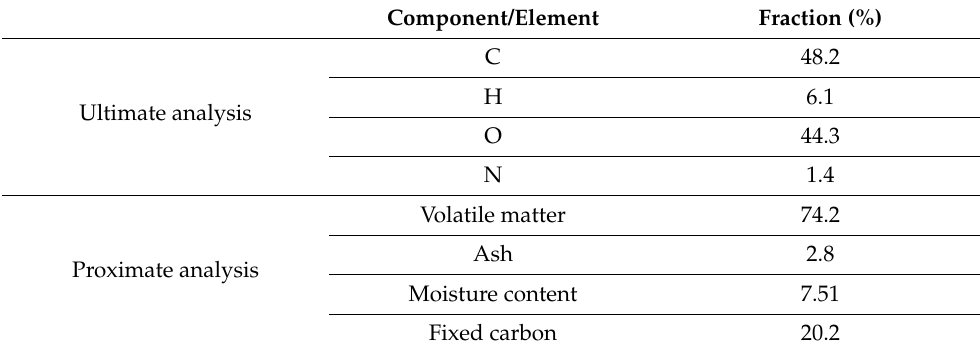
Figure 1. Photo of raw olive pomace (ROP). Table 1. Components, ultimate and proximate analysis of the raw olive pomace [4].